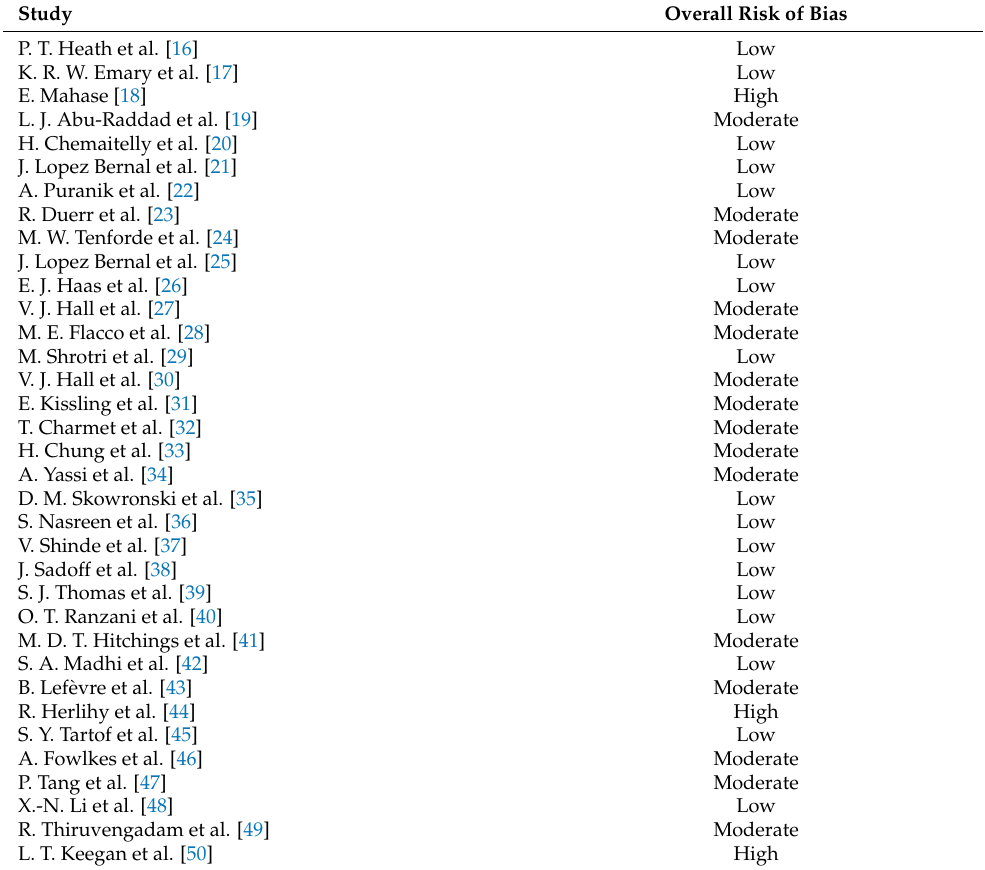
Table 1. Risk of Bias